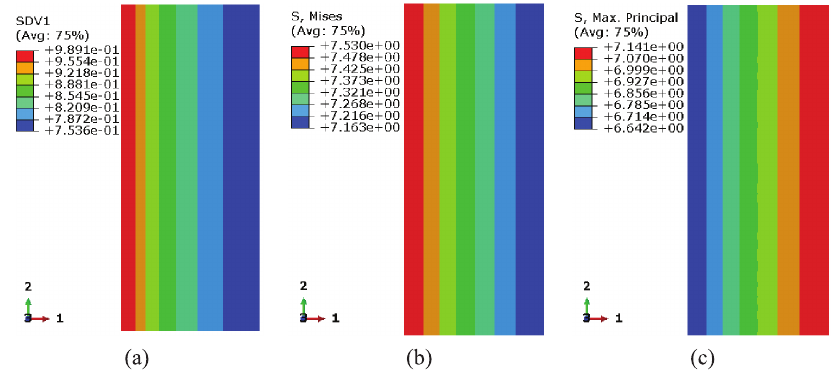
Fig. 8: The distribution of SDV1, σ e and σ p after operating for 261,000 h at 950 °C: (a) SDV1; (b) σ e ; (c) σ p